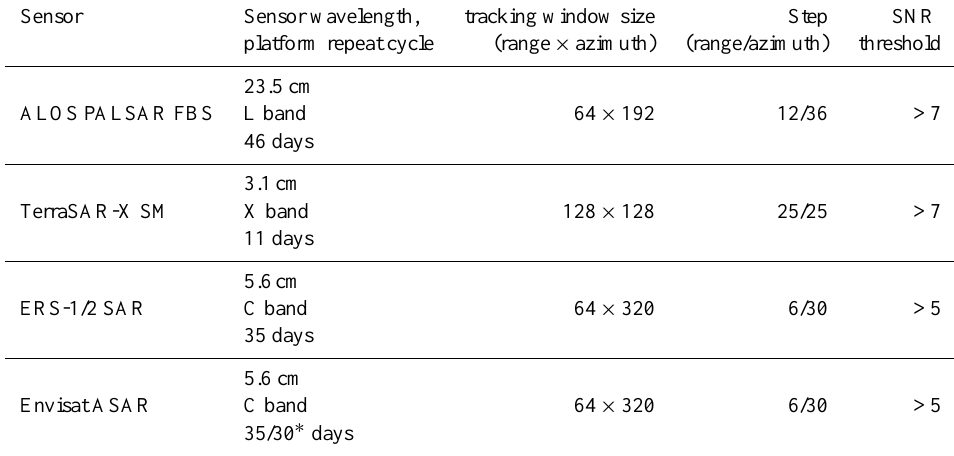
Table 1. Overview of sensors used for velocity mapping and their main characteristics. The parameter settings for feature tracking, such as tracking window size, step size, and SNR threshold for discarding unreliable measurements, are also listed per sensor.